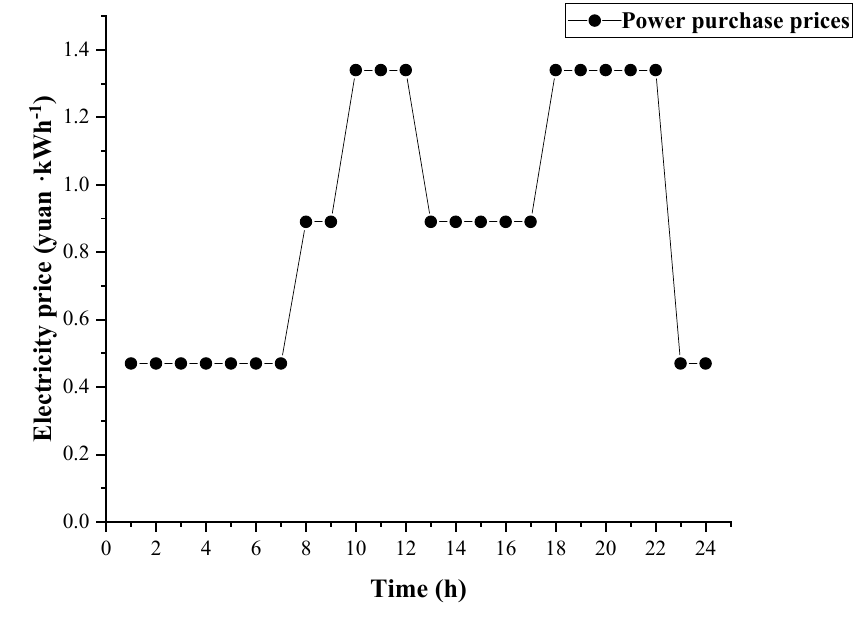
Figure 4. Electricity acquisition price of EH.